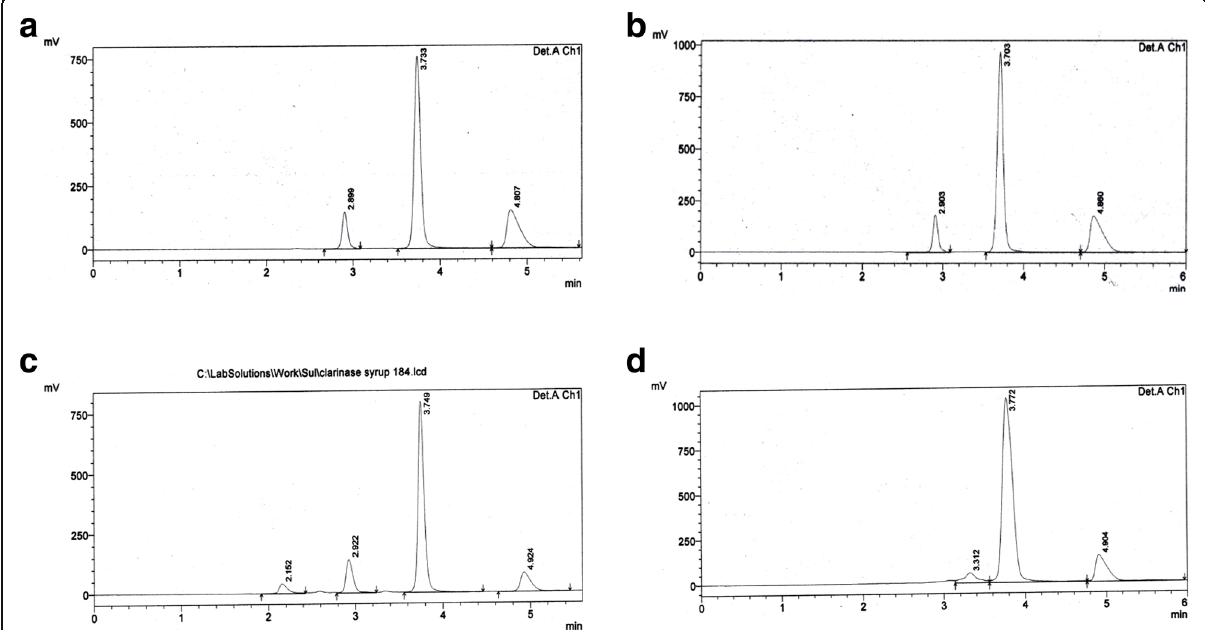
Fig. 3 Typical chromatograms of a optimization mixture, b standard solution, c Lorinase syrup, and d Clarinase tablets. SB = 2.90 min, LOR = 3.70 min, and PSE = 4.80